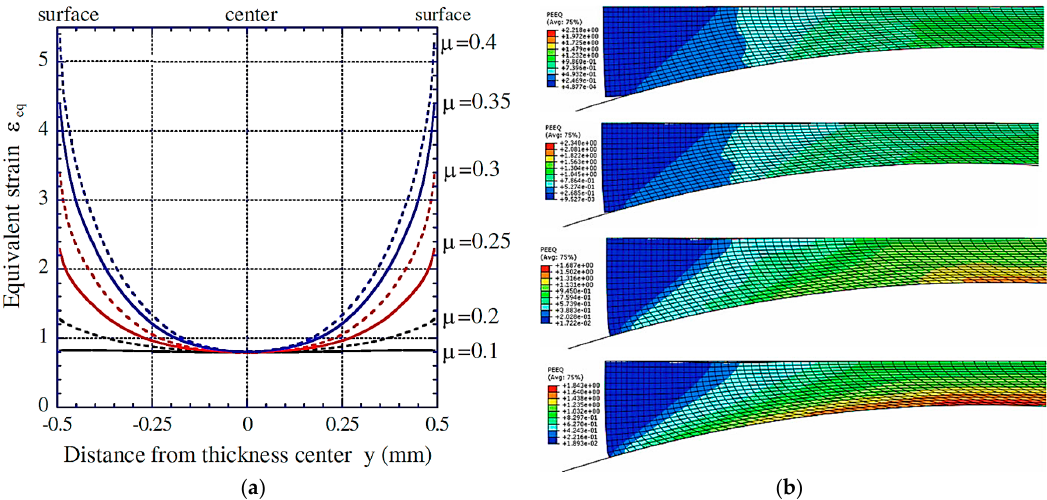
Figure 23. ( a ) equivalent strain through sheet thickness for varied friction coefficients [144], ( b ) the equivalent plastic strain contours obtained at 300 °C for different roller/sheet friction coefficients [147].